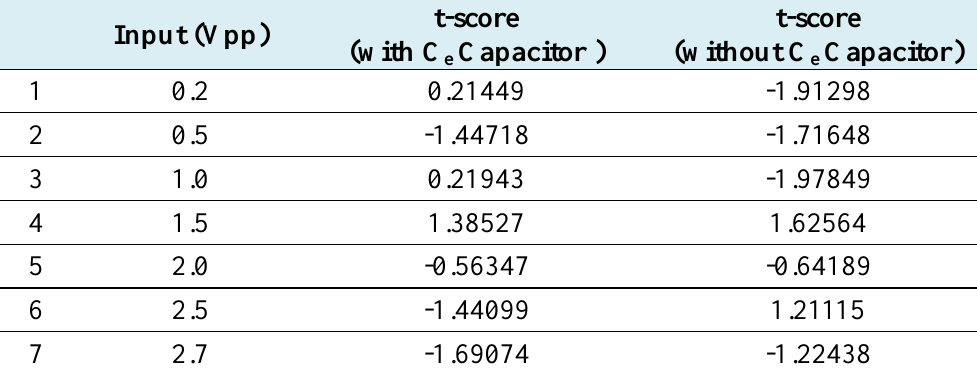
Table 2 Statistical analysis of FFL and ORL output